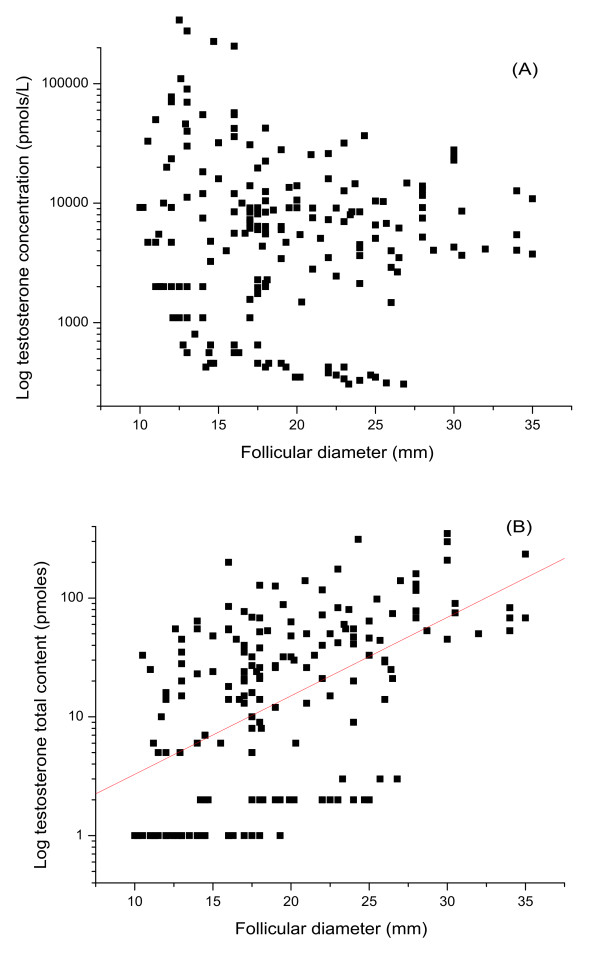
Follicular testosterone. Scatter plots to show the correlation of testosterone concentration (pmoles/L) (a) and total content (pmoles) (b) with follicular diameter (mm). The concentration of testosterone did not correlate with follicular diameter (3a), but total content increased with the follicular size (3b) (r = 0.52, p < 0.001).